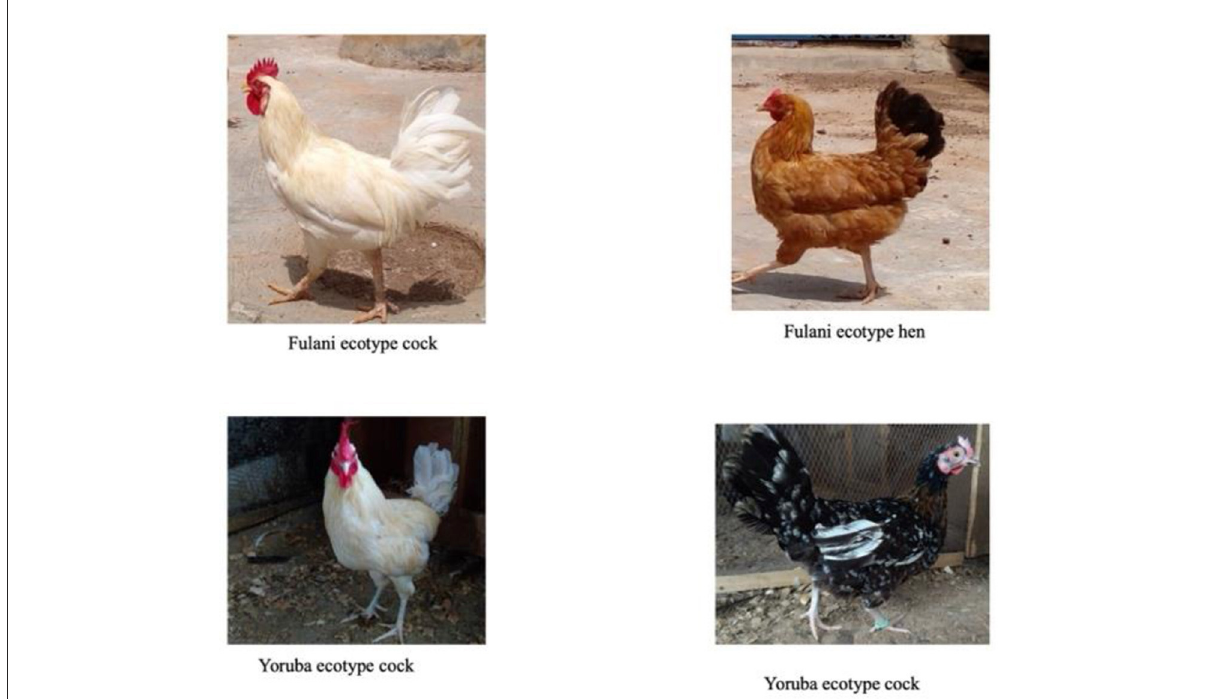
FIGURE1 Fulani and Yoruba ecotype chickens.